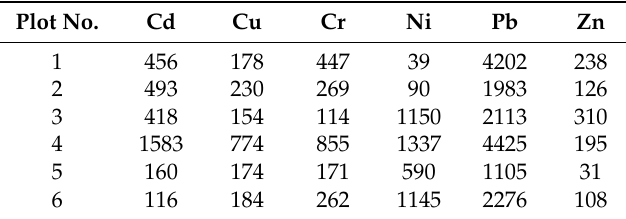
Table 6. Values of the mobility ratio (ratio of metal concentration in soil (0–25 cm)) to its concentration in groundwater in the area of the MSW Łubna landfill. Plot